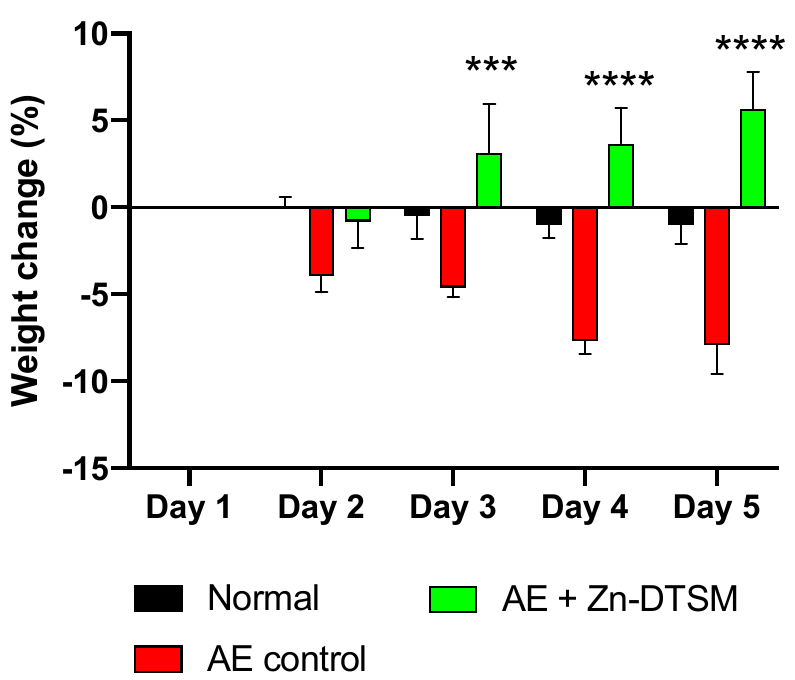
Figure 4. Weight change data (%) for older (5-month) AE animals treated with Zn-DTSM (30 mg/kg/day). These older AE control animals again lose weight as expected across the five days of the experiment, and this is significantly different to the naïve animals (“normal”) on days 2–3 ( p < 0.05) and days 4–5 ( p < 0.001). The administration of Zn-DTSM alone results in a profound shift in the phenotype such that the animals gain significant amounts of weight over the time course. Data are mean ± SEM. *** p < 0.001, **** p < 0.0001 (all compared to AE control).